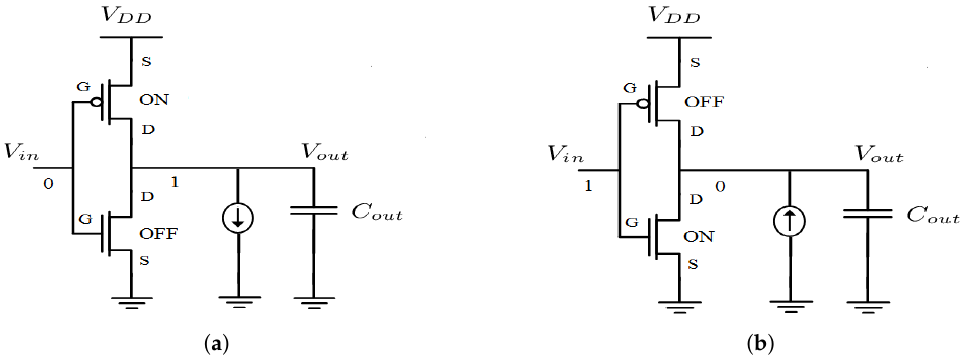
Figure 1. Modeling of the particle strike on an inverter via the current pulse when ( a ) it occurs on NMOS transistor and ( b ) on PMOS